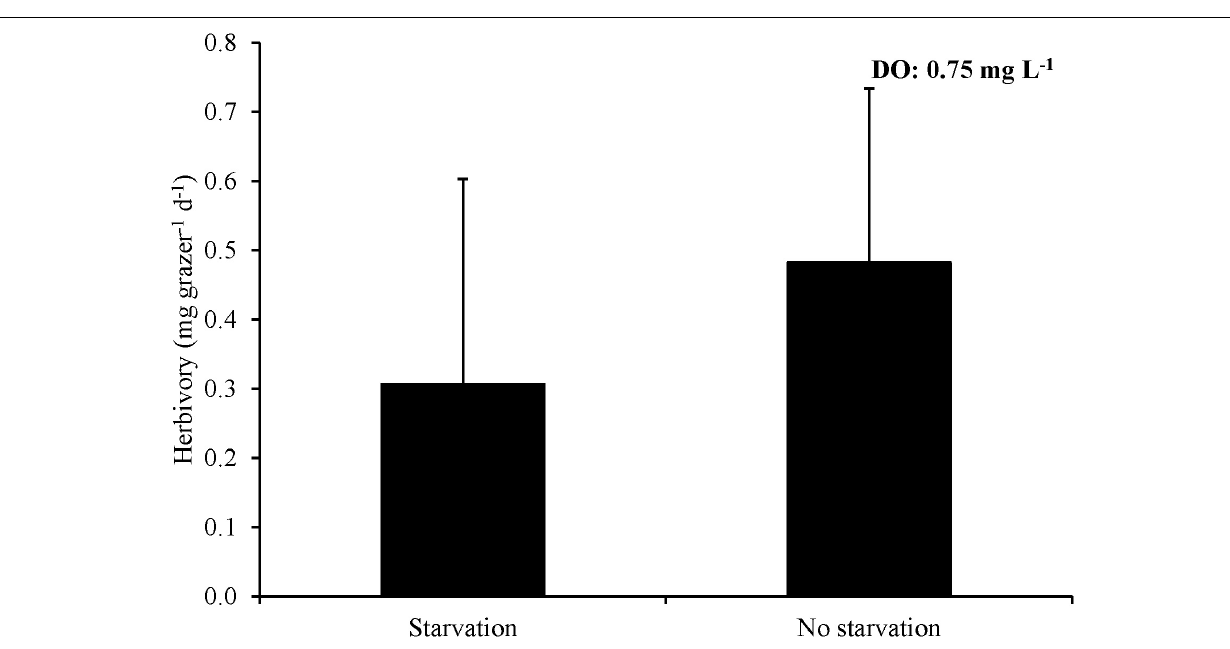
hour exposure treatment as well as the no exposure control (One-way ANOVA and Tukey HSD; p < 0.05; Figure 8 ; Supplementary Tables S15, S16 ). L. vincta survival was 100% in all treatments. Finally, for Experiment 9, starving snails